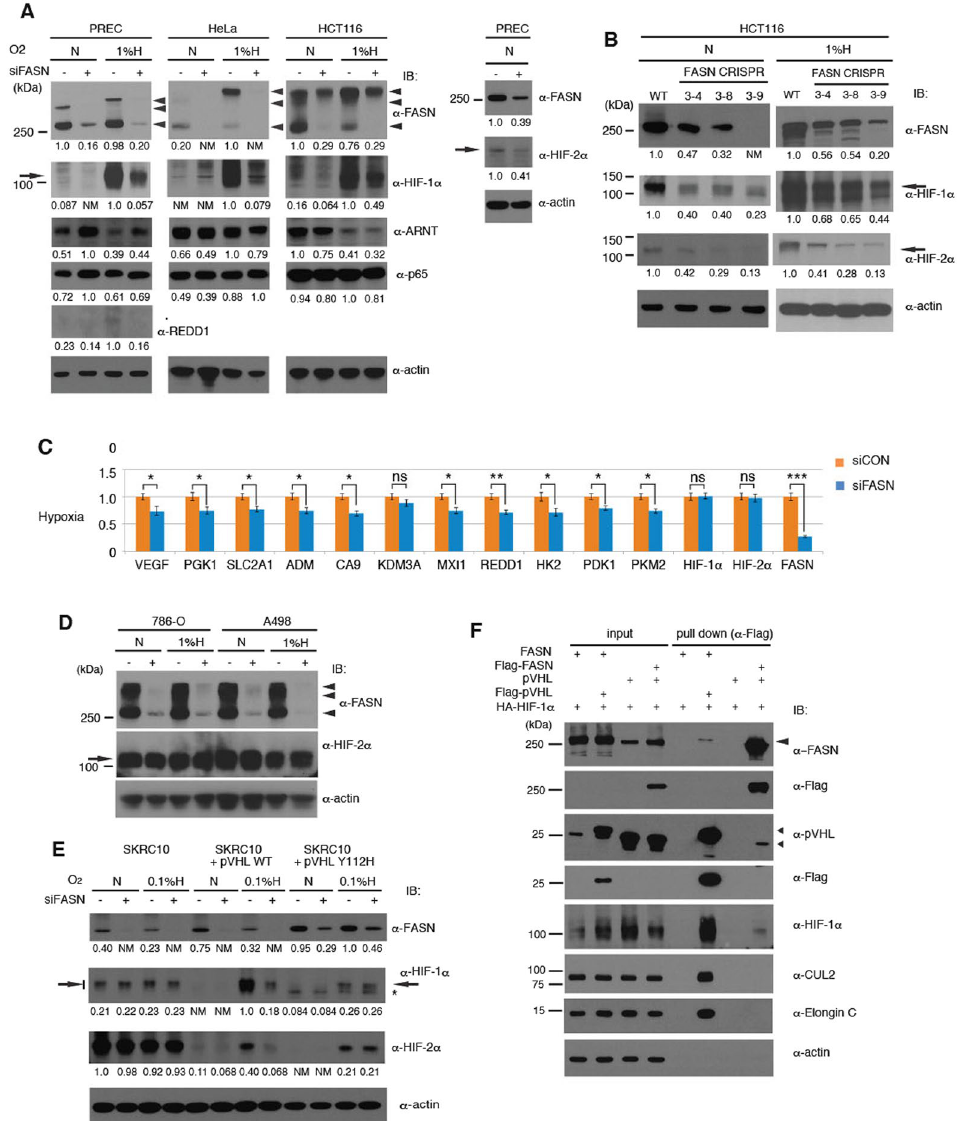
Figure 3. FASN Regulates HIF- α Protein Stability and HIF Target Gene Expression. ( A ) FASN siRNA downregulates HIF- α protein levels. PREC, HeLa and HCT116 cells were treated with FASN ( + ) or control ( − ) siRNA and harvested after 72 h. Cells were exposed to hypoxia (1% oxygen) or maintained in normoxia (21% oxygen) 4 h before harvesting and subjecting WCEs to western blot analysis. Unmodified (250 kDa) and modified (larger) FASN bands are indicated by large arrowheads, REDD1 by a small arrowhead, and HIF-1 α and HIF-2 α by arrows. ( B ) Downregulation of HIF-1 α and HIF-2 α in HCT116 cell clones carrying the FASN gene mutagenized using CRISPR-Cas9 (See Supplementary Fig. S3 for genomic DNA information). Protein samples were prepared in normoxia (left column) or hypoxia (right column) for western blot analysis. Asterisk indicates a non-specific band. ( C ) Quantification of HIF-target gene expression by qPCR upon downregulation of FASN in PREC. Samples were prepared from cells treated as described for panel A but with 24 h hypoxia. siRNAs were transfected in triplicates and mRNAs of the HIF target genes were measured in biological triplicates and technical duplicates as a total of 6 samples by qPCR. Values were normalized against the PPIA reference gene and control samples. ( D ) Loss of downregulation of HIF-2 α levels in ccRCC cells. pVHL-deficient 786-O and A498 cells were tested in FASN siRNA knockdown experiments. ( E ) Restoration of HIF- α regulation by stable expression of exogenous pVHL in SKRC10 cells. pVHL-WT or pVHL-Y112H were introduced into pVHL-deficient SKRC10 ccRCCs using a lentiviral vector carrying a weak promoter and HIF- α protein levels were examined. Specific and non-specific bands are indicated by arrows and an asterisk, respectively. ( F ) FASN and the E3 ligase components are present in the pVHL-containing complexes in a mutually exclusive manner. The indicated constructs were transfected into 293 T cells and WCEs prepared after 48 h were tested for protein-protein interactions by precipitation with an anti-Flag antibody-conjugated resin. Note that FASN failed to precipitate CUL2 and Elongin C, as shown in lanes 6 and 8. Experiments were repeated twice ( D , E , F ) or more ( A , B ), and the results were reproduced. The qPCR experiment ( C ) was performed once with biological